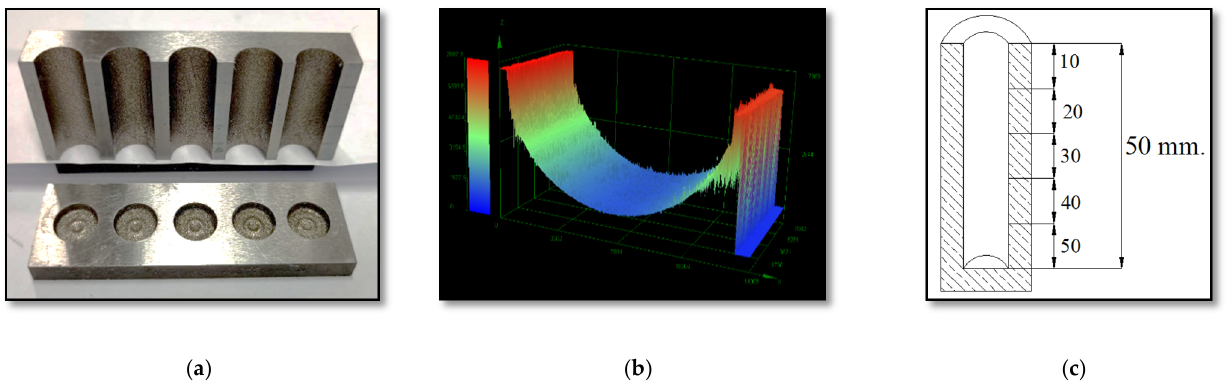
Figure 3. The gap clearance profiles: ( a ) dismembered AISI P20 tool steel workpieces, ( b ) maximum gap clearance (GC) distortion measurement, ( c ) locations of GC distortion measurement.